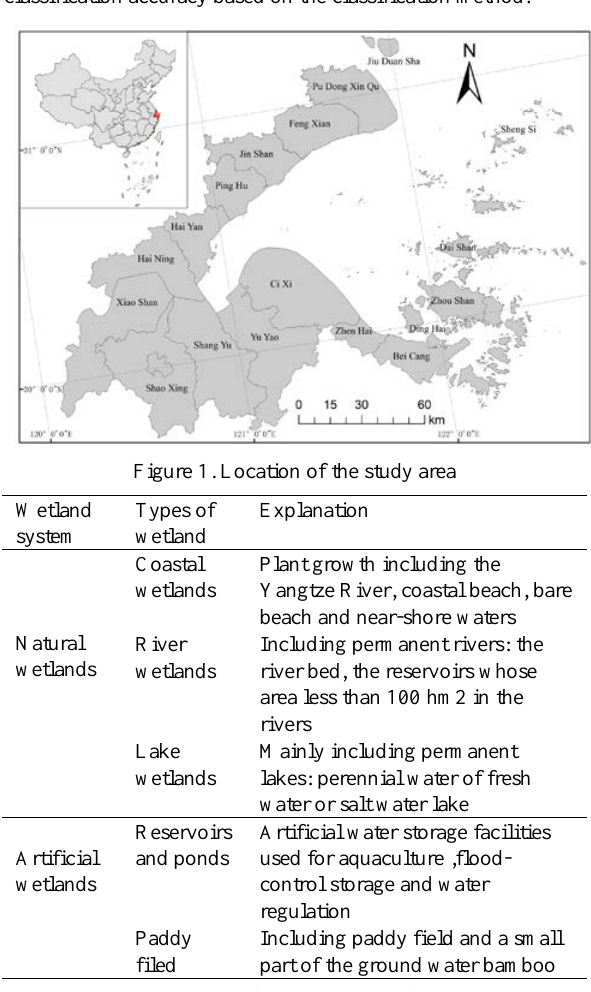
Table 1. Wetland classification system of Hangzhou Bay